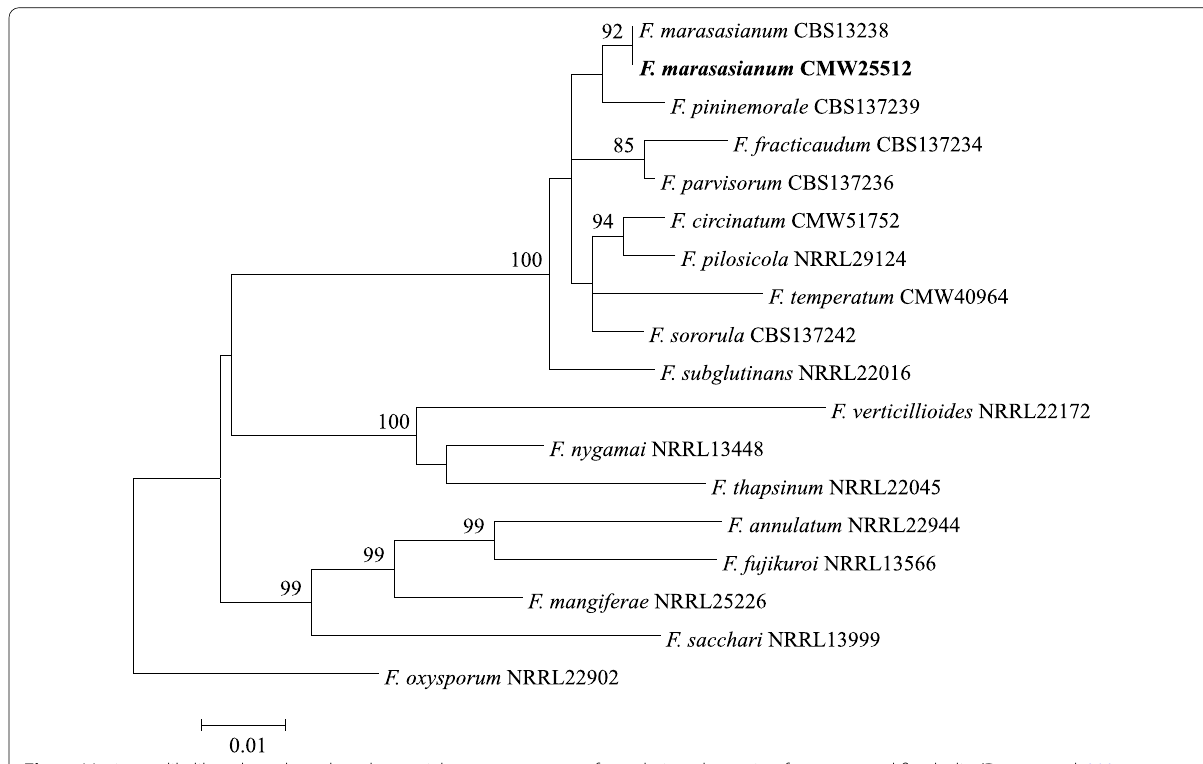
Fig. 1 Maximum likelihood tree based on the partial gene sequences of translation elongation factor 1-α and β-tubulin (Duong et al. 2021; Herron et al. 2015; Wingfield et al. 2015a, 2018a). Values at branch nodes are the bootstrapping confidence values with those marasasianum isolate sequenced in this study is indicated in bold; F. marasasianum CBS 137238 is